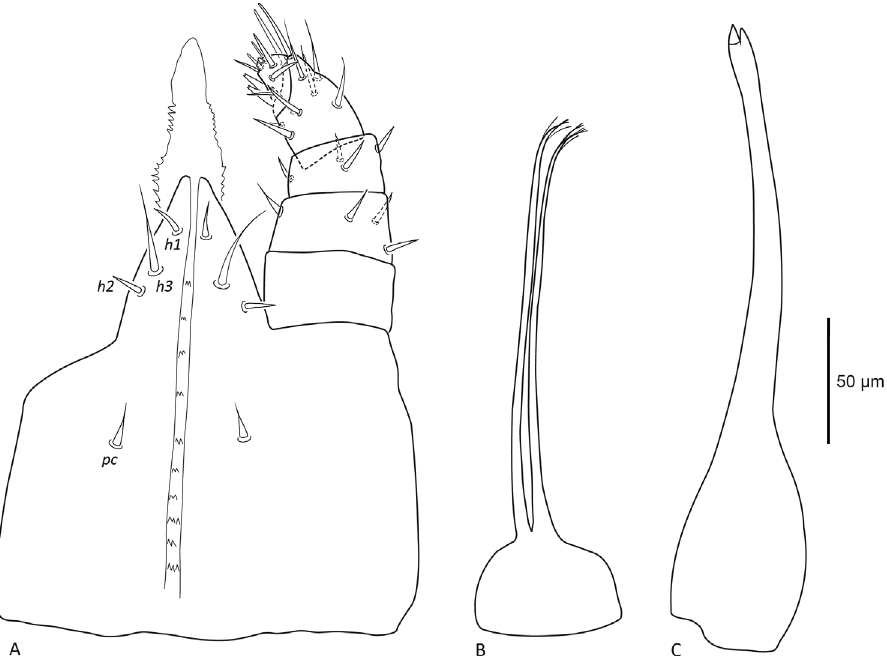
Figure 8. Female Vitznyssus erici sp. n. (A) subcapitulum and palp, ventral aspect; (B) tritosternum; (C)